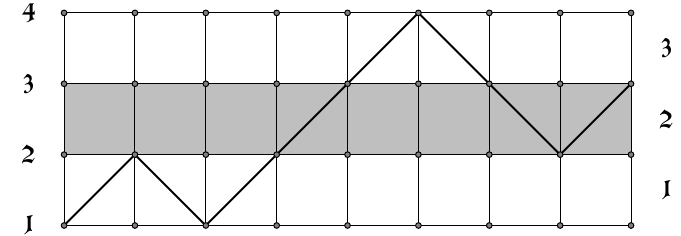
Figure 4 . A non-minimal path in the restricted solid-on-solid model L p;p 0 = L 2 ; 5 , labeled by a = 1, b = 2, and c = 3.